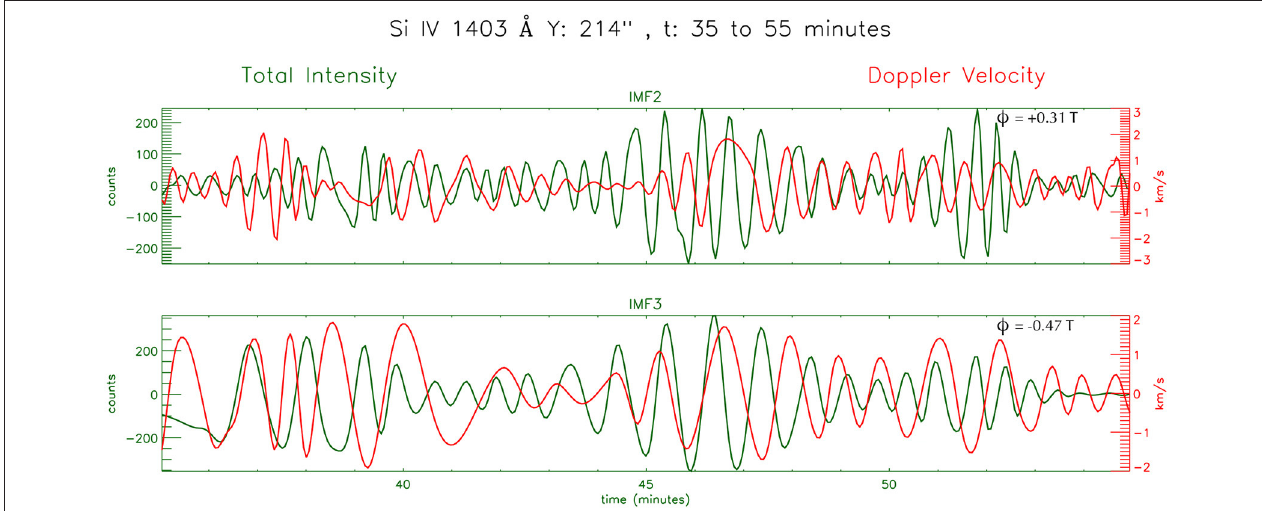
FIGURE 10 | Representative examples of the IMFs at location B along the slit, showing the respective comparisons between Doppler velocity and total intensity oscillations, and depicting that the phase-shift between them changes continuously.